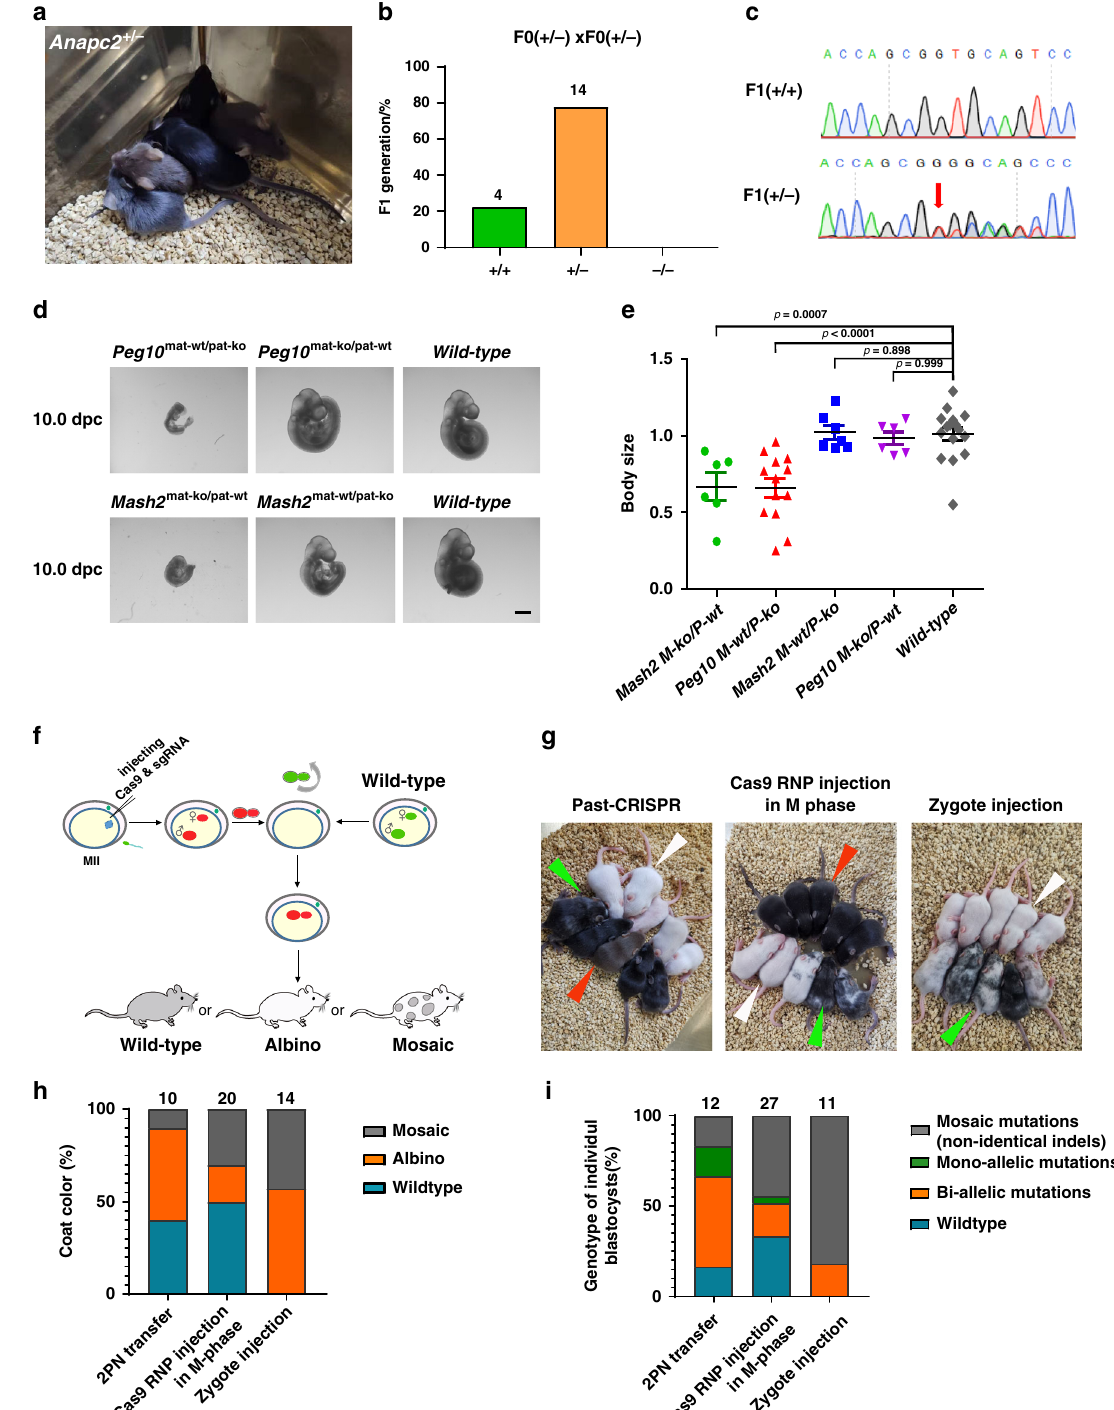
Speci fi c disrupting of dominant alleles to block dwar fi sm . Next, we want to test whether Past-CRISPR can be used for treating dominant genetic diseases. By analyzing the human genetic var- iants in the ClinVar database 30 , we screened 1789 dominant pathogenic variants from a total of 81,137 pathogenic entries (Supplementary Fig. 8a and Supplementary Data 1, 2), from which the function of the dominant mutant allele affects the phenotype even in the presence of a wild-type allele. Thus, allele-speci fi c disruption of the dominant allelic mutations could